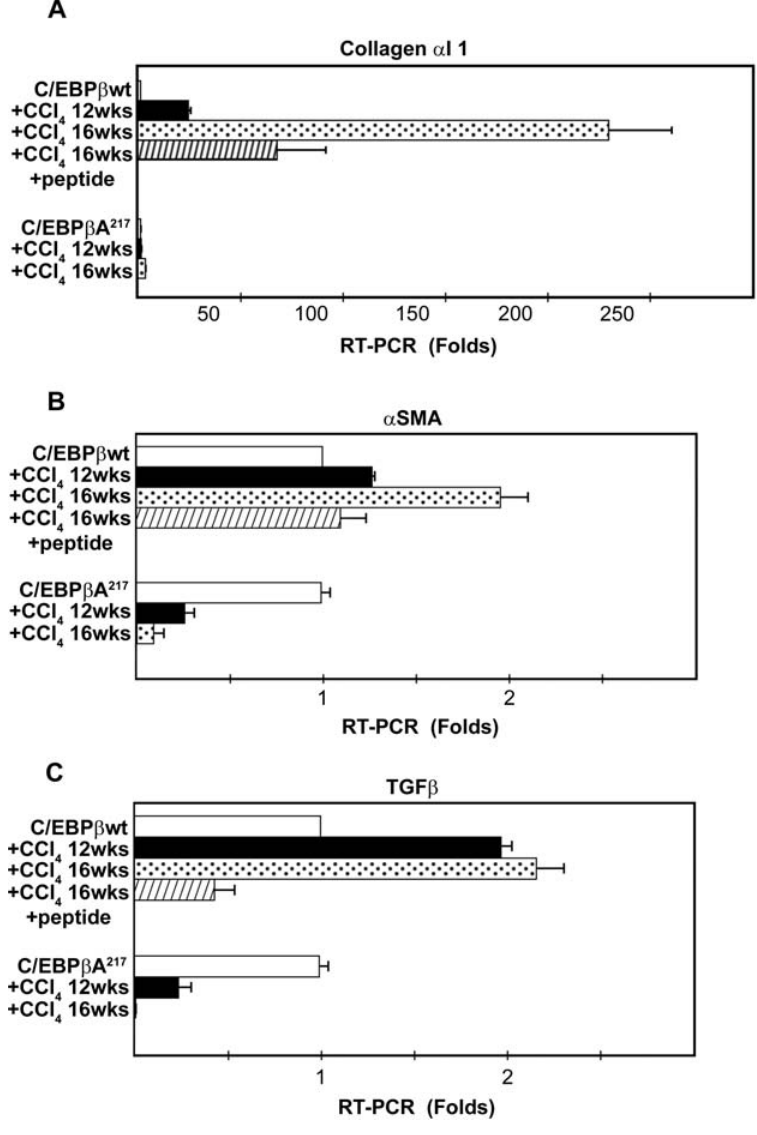
Figure 2. Mice expressing the RSK-inhibitory C/EBP b -Ala217 transgene are resistant to hepatotoxin-induced liver fibrogenesis. Mice were treated with